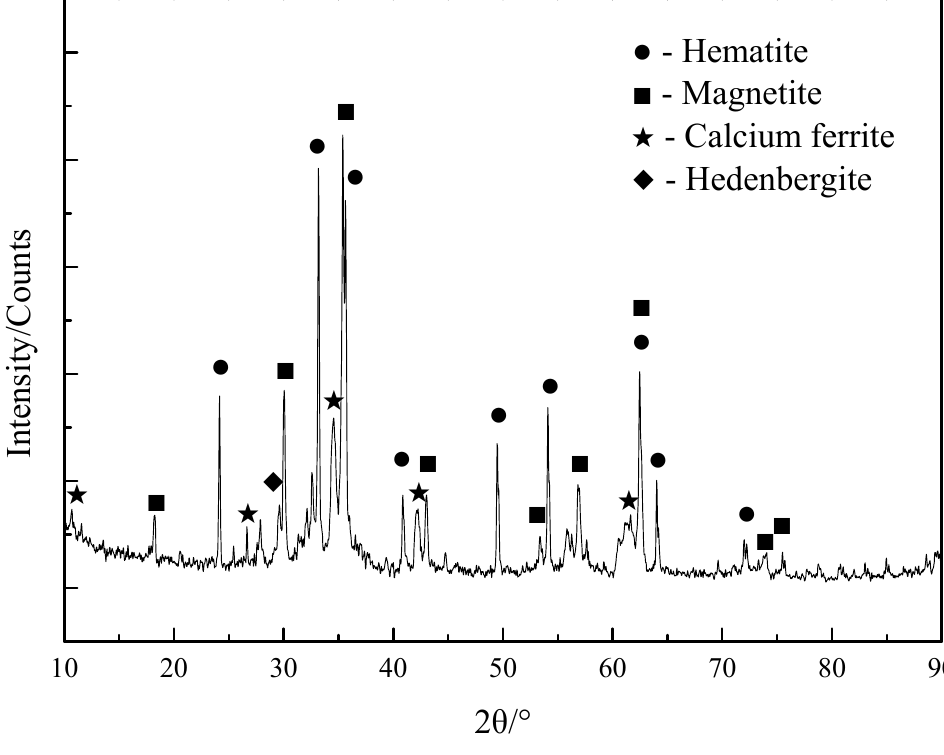
Figure 1. XRD analysis of catalyst.